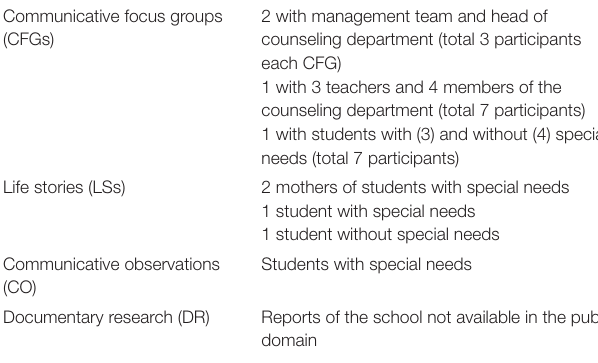
TABLE 2 | Data collection